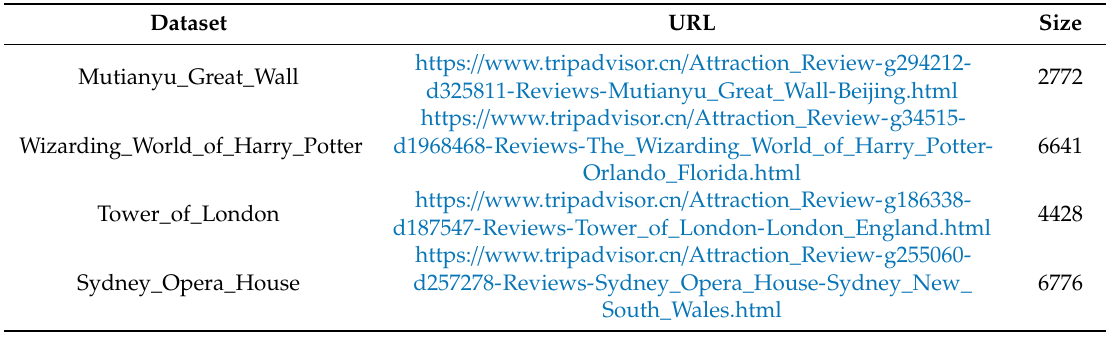
Table 2. Experimental data set.